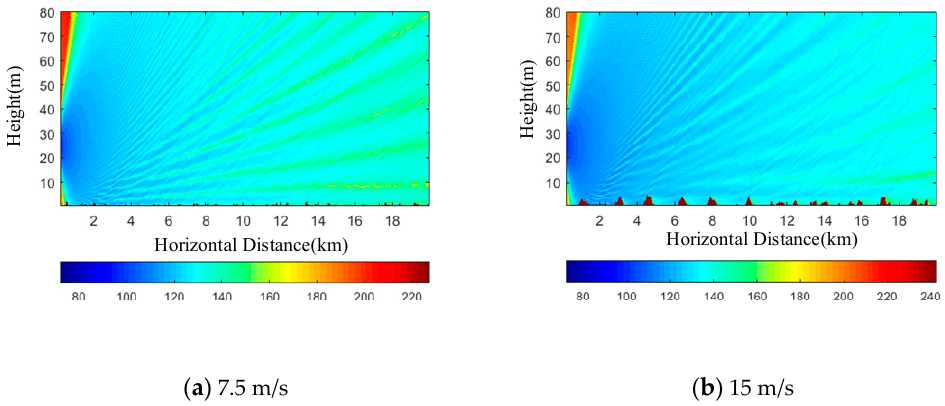
Figure 8. The pseudo-color map of propagation loss distribution. It gives propagation loss pseudo-colour map of the vertical profile when the sea surface wind speed is: ( a ) 7.5 m/s and ( b ) 15 m/s. The evaporation dust has a dust height of 20 m. The signal frequency is 8 GHz.